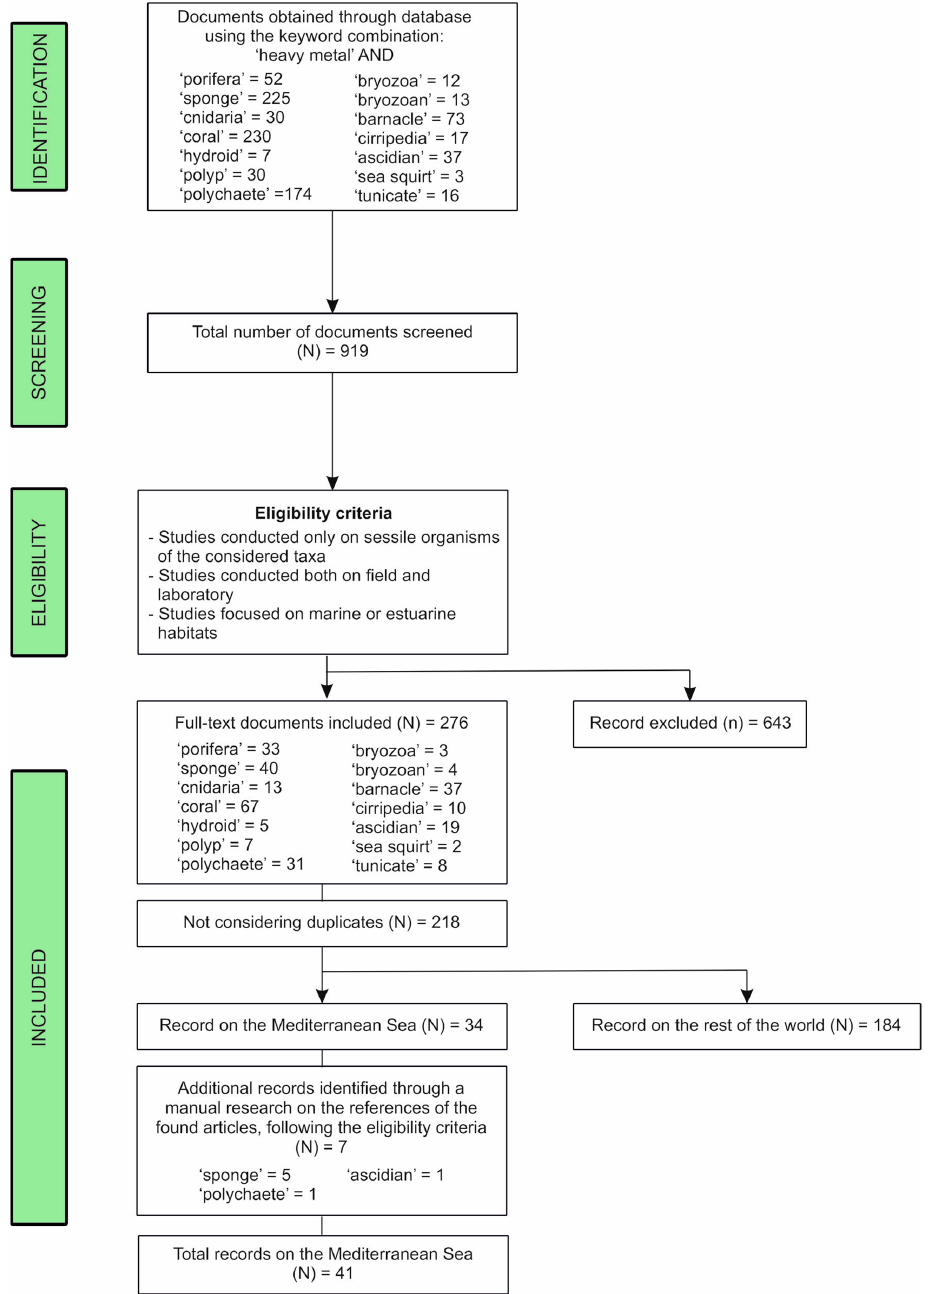
Figure 1. Flow chart illustrating the steps for obtaining documents about the study of heavy metals (HMs) on organisms from Scopus search engine and from the manual research.